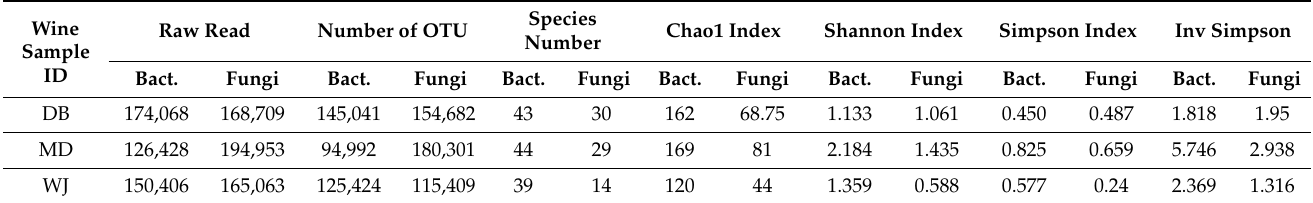
Table 1. Sequence abundance and microbial diversity of wine